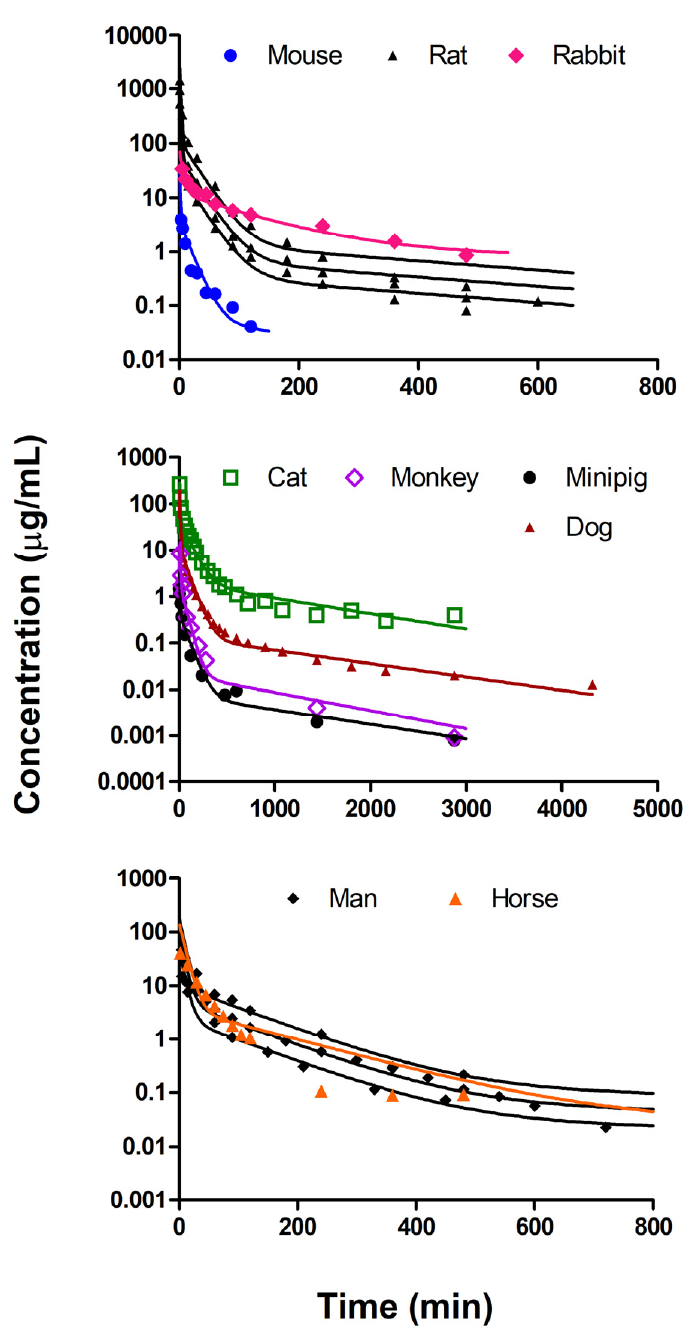
Figure 3. Simultaneous fitting of metformin pharmacokinetics dosed intravenously in 9 species to the minimal physiologically based pharmacokinetic model in Figure 2. Fitted profiles are in separate panels for visual clarification for the indicated species. The doses and fitted parameters are listed in Tables 1 and 2. The three curves for man are for different doses from three